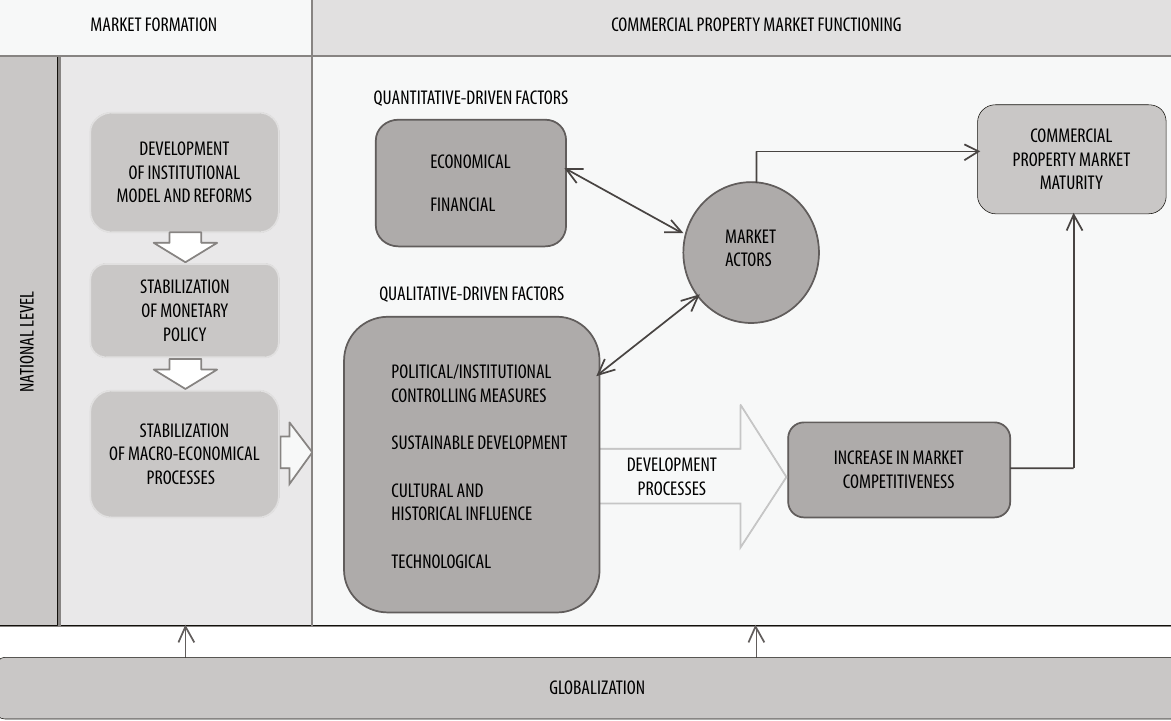
Fig. 3. Model of property market